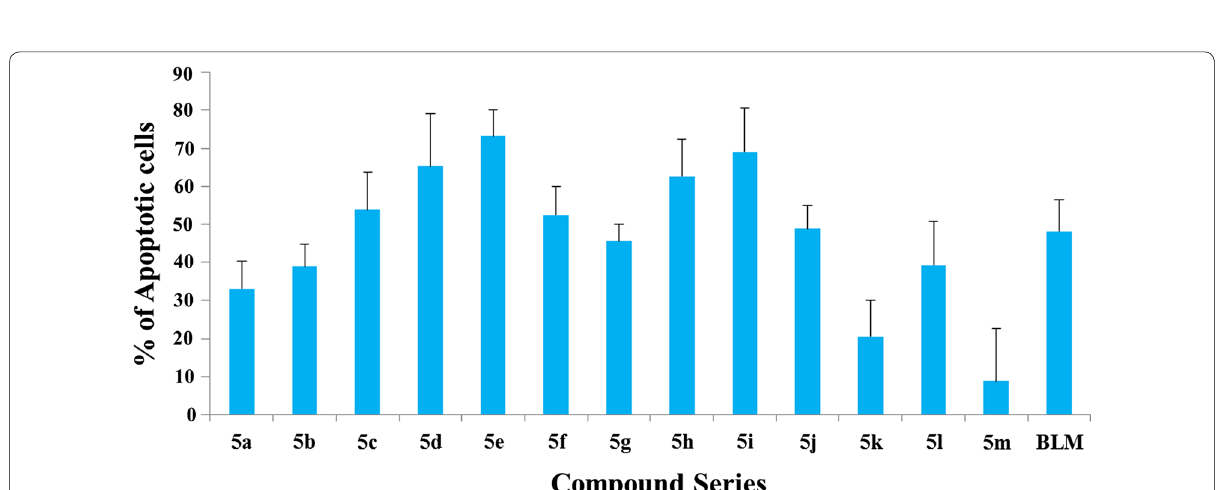
Fig. 4 AO/EB dual staining data showing the response of FaDu hypopharyngeal cancer cells exposed to synthesized compounds 5 ( a – m ) and bleomycin at 48 h, in terms of apoptosis. The percentage of apoptotic cells is indicated by the histograms. The data shown are the means from